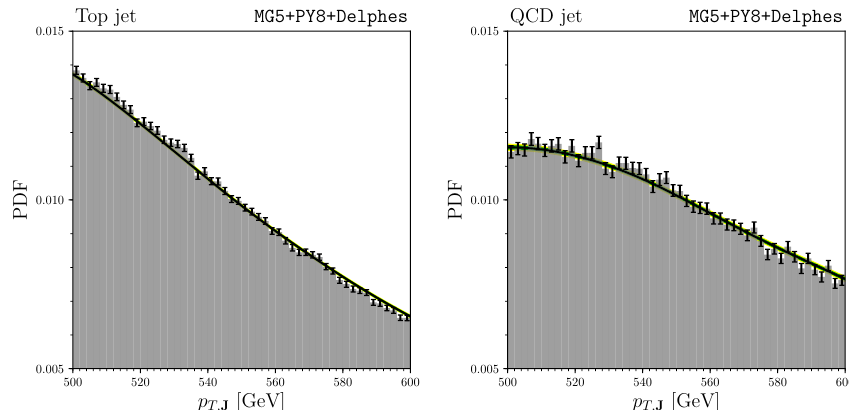
Figure 23. The histogram and modeled probability density distribution of p T; J for (left) top jet samples and (right) QCD jet samples. Solid black line is the KDE. The vertical bar is the statistical uncertainty of each bin. The green and yellow bands are pointwise statistical uncertainty of the KDE calculated from squared sum of the